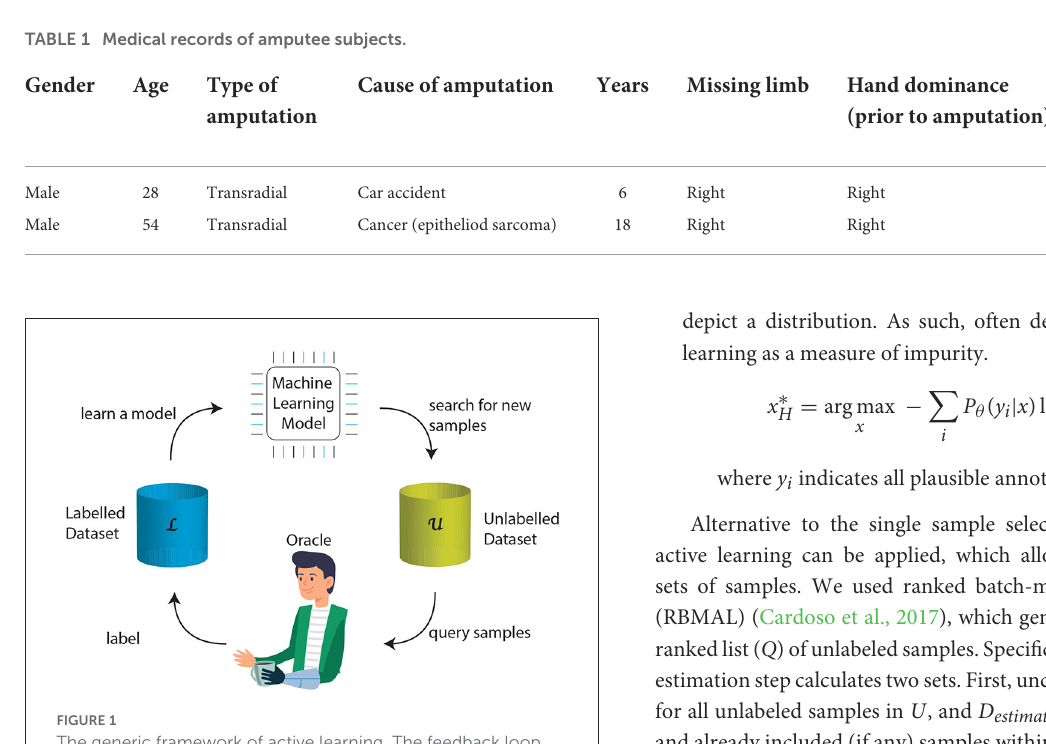
FIGURE1 The generic framework of active learning. The feedback loop includes a small set of labeled data L that is used to train a machine learning model. Based on that, the active learner explores a large pool of unlabeled data U and selects new samples. These samples are then passed to an oracle, which would be a prosthesis user in this paper, for labeling. These samples join the training set for model